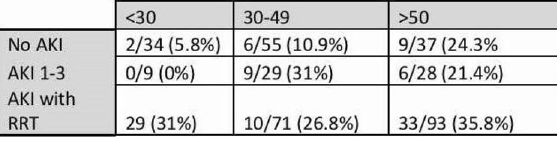
Table 2 (abstract 001469). % Death per Age group and AKI